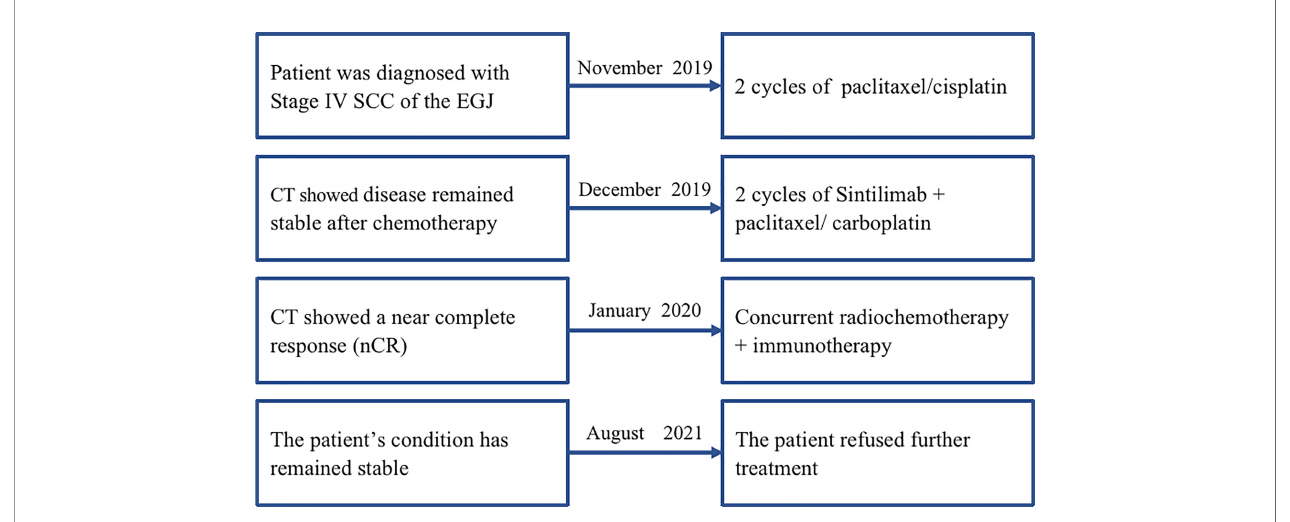
FIGURE 2 | The timeline of diagnosis, interventions, and outcomes of case 1. SCC, squamous cell carcinoma; EGJ, esophagogastric junction; CT, computed tomography; cCCR, concurrent